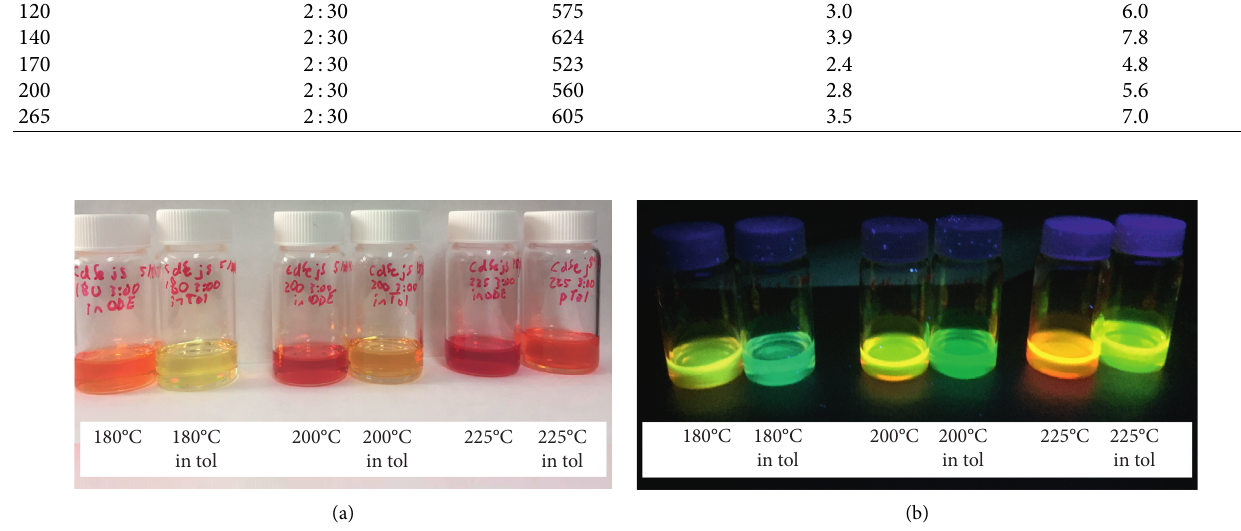
Figure 4: Images of QDs under visible light (a) and under 365nm UV light (b) just before cleaning (left in each pair) and after resuspension in toluene (right in each pair). The batches were made with a hold time of 3min and represent the following temperatures: 180 ° C (left pair), 200 ° C (middle pair), and 225 ° C (right